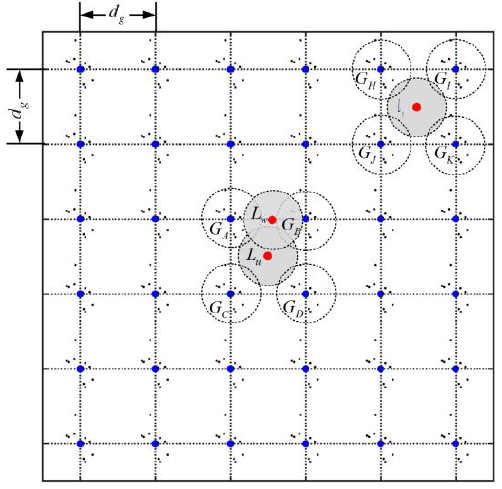
Figure 1. The group-based random deployment strategy for WSNs.